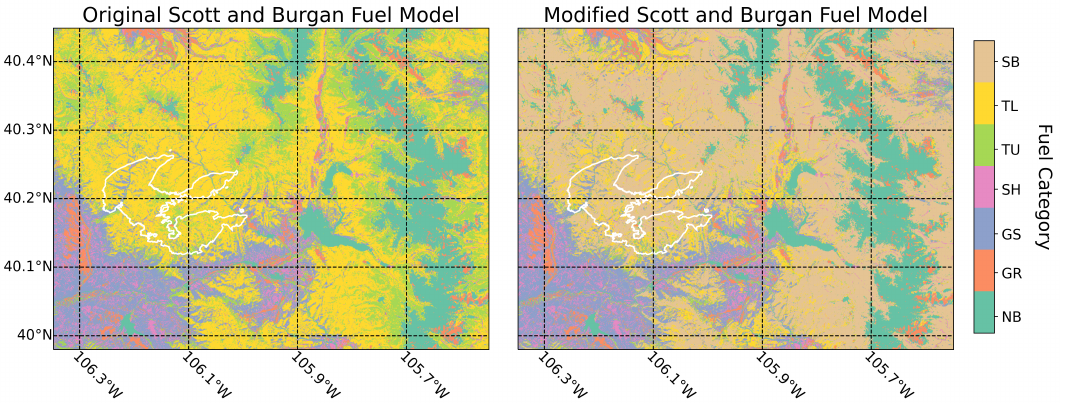
Figure 3. The original ( left ) and modified ( right ) Scott and Burgan fuel model layers used in the WRF-Fire simulations. The active fire perimeter used to initiate the simulations is shown in white. Fuel categories represent the fuel type of the fuel model; slash–blowdown (SB), timber litter (TL), timber–understory (TU), shrub (SH), grass–shrub (GS), grass (GR), and nonburnable (NB).